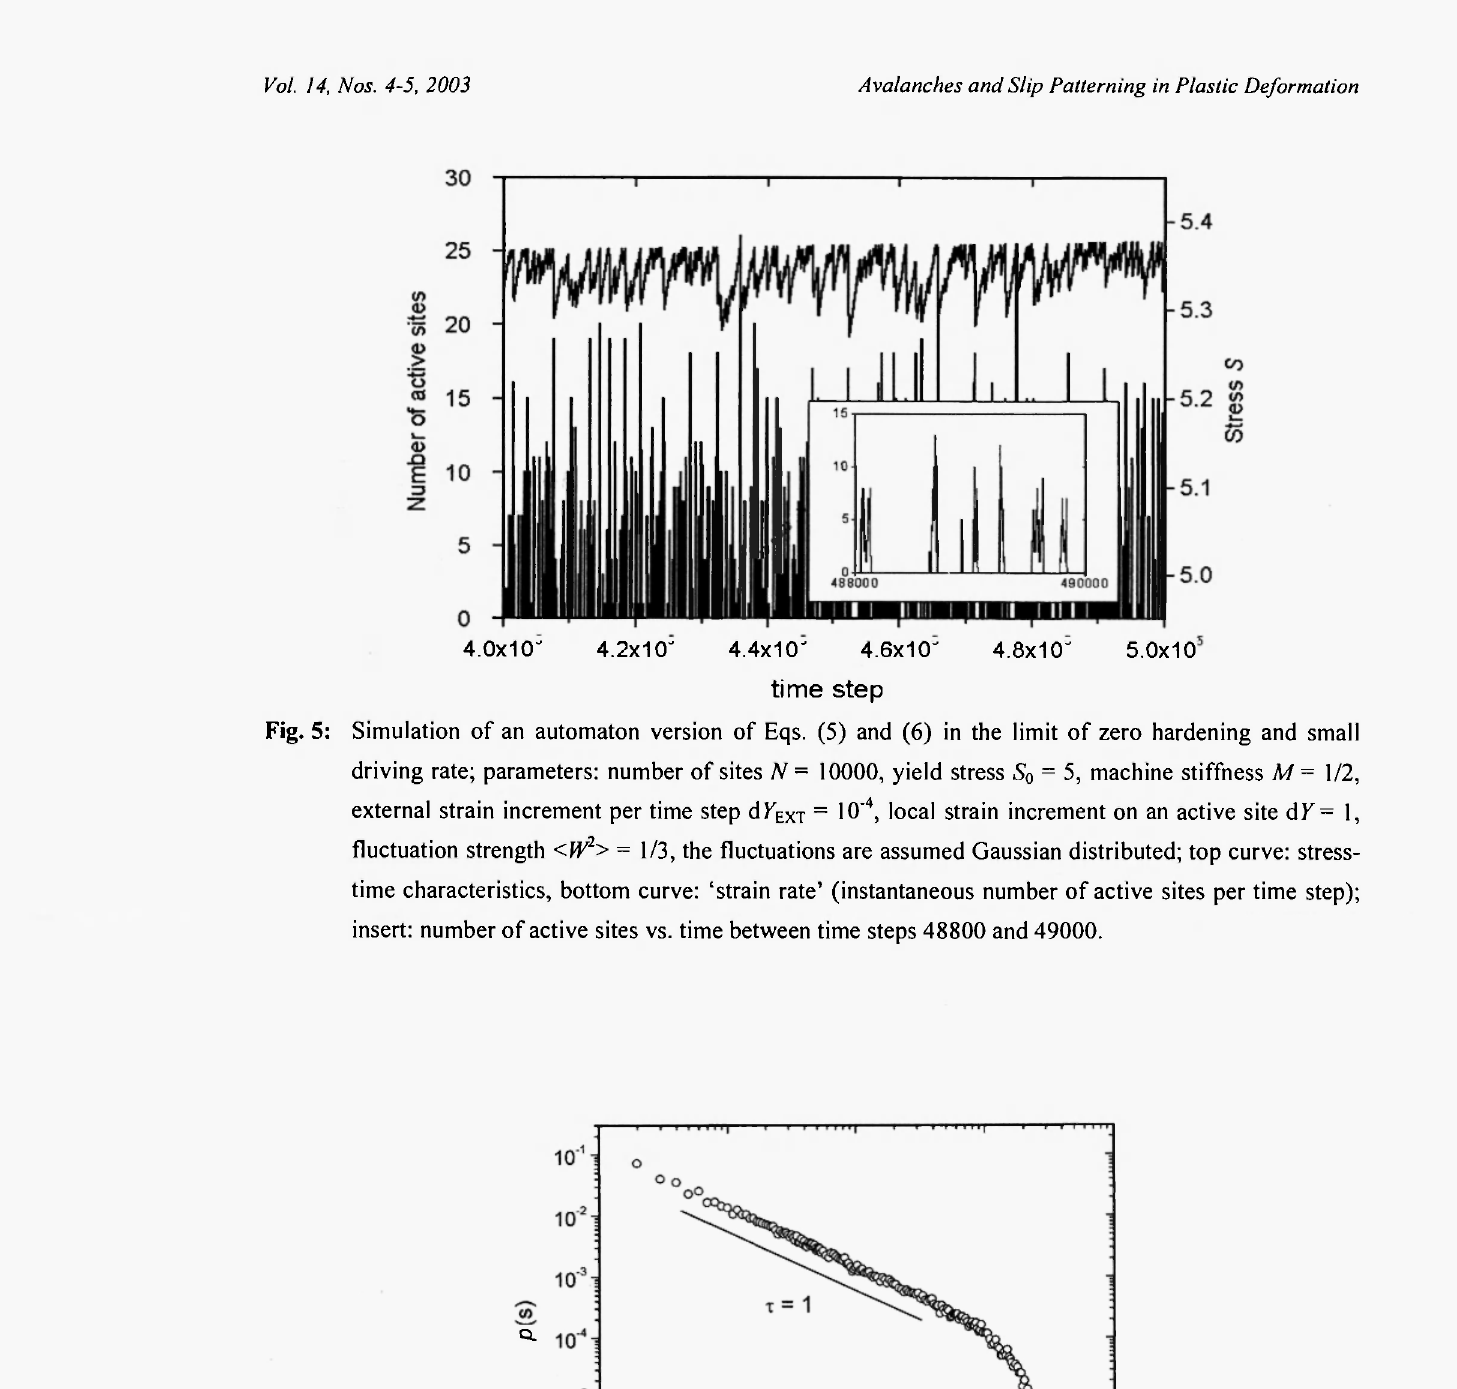
Fig. 6: Avalanche size distribution obtained from automaton simulation for the same parameters as in Fig.